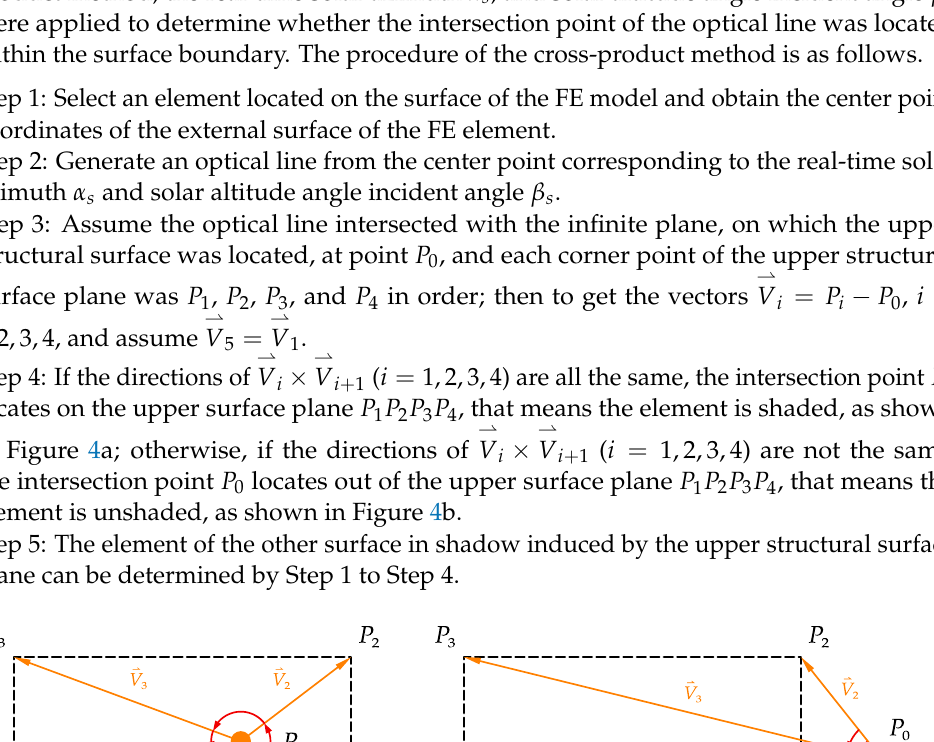
Figure 4. Schematic diagram of the cross-product method. ( a ) the point